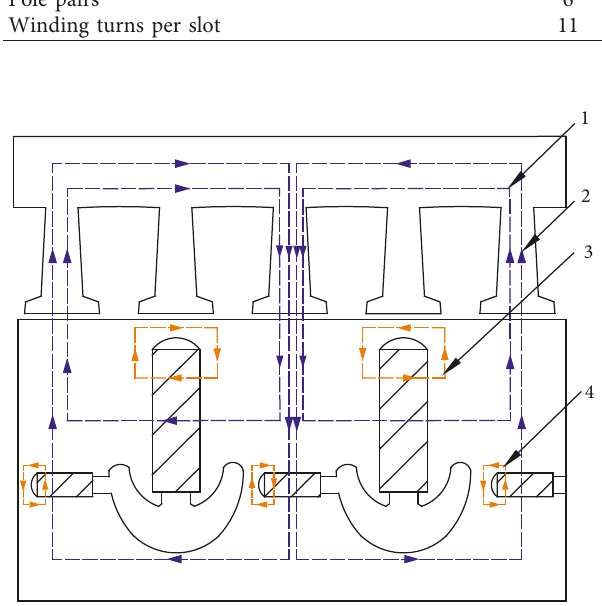
Figure 2: Diagram of magnetic flux of ITQPMG. (1) The main magnetic flux of tangential PM steel. (2) The main magnetic flux of radial PM steel. (3) The leakage flux of tangential PM steel. (4) The leakage flux of tangential PM